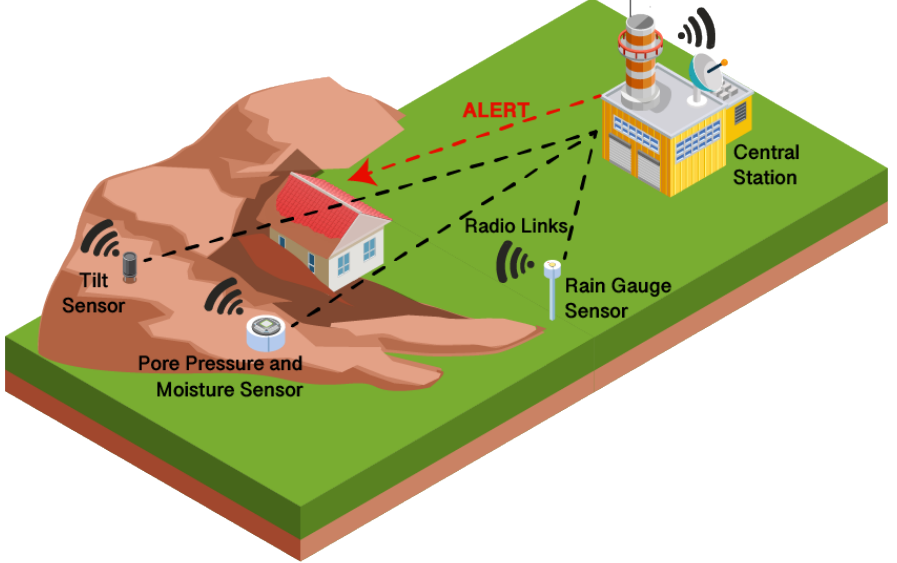
Figure 5. Example implementation of a Landslides Early Warning System based on the IoT and underwater